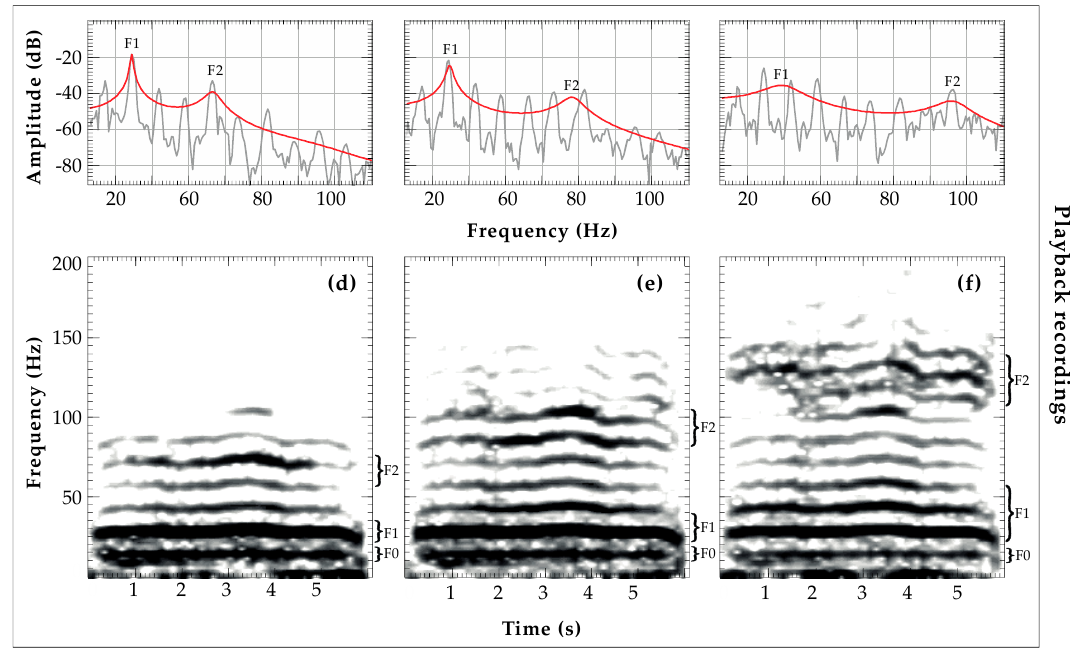
Figure 3. Narrow ‐ band spectrograms and LPC spectra, indicating f o , F1 , and F2 location for each shift variant (25% Down, 0% Unchanged, and 25 % Up) of the original test data set ( a – c ) and the corresponding playback recordings from 50 m distance ( d – f ) (S_Tools ‐ STx settings; analysis windows: Kaiser kessel, bandwidth: 2, overlap: 75%).